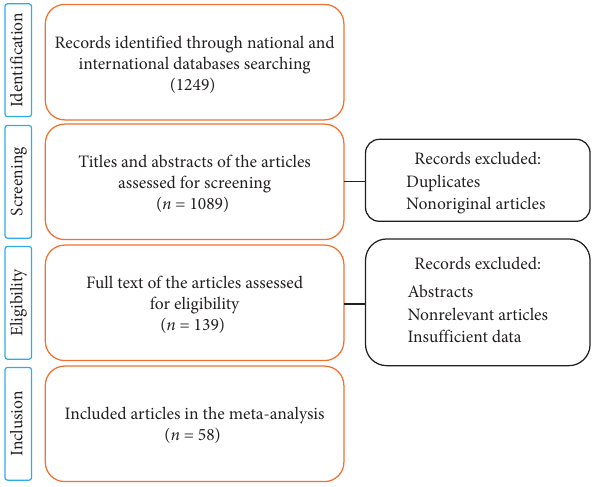
Figure 1: Flow diagram of literature search and study selection.